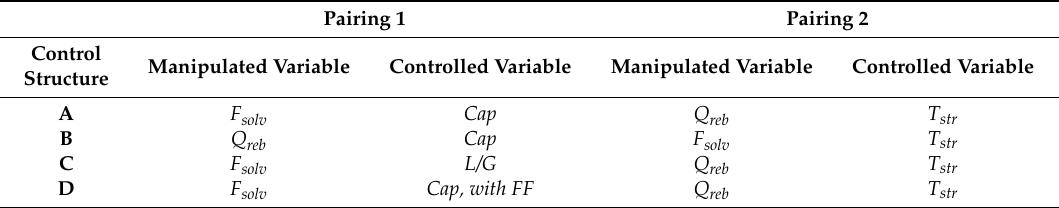
Table 7. Control structures for the supervisory control layer of the TCM amine plant. Key manipulated variables (MVs) are solvent flow rate F solv and reboiler duty Q reb . Controlled variables are CO 2 capture ratio Cap to 85%, defined in Equation (12), and stripper bottom temperature T str to 120.9 ◦ C. Control structure D controls Cap via a feed forward FF